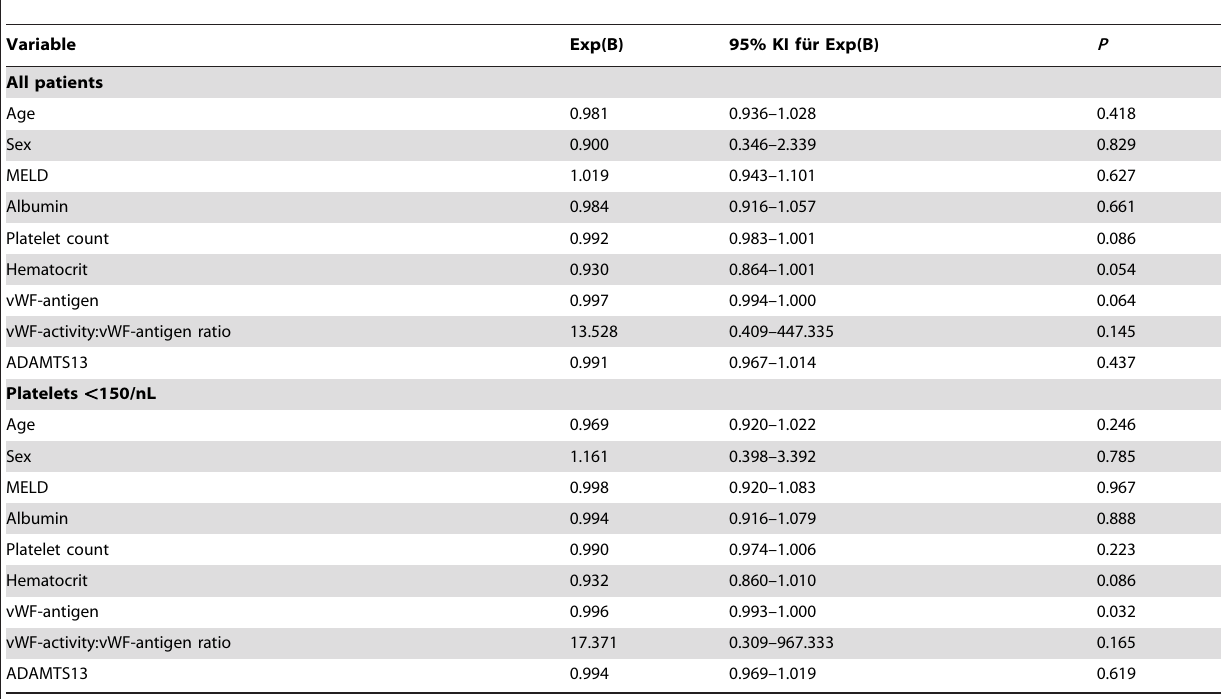
Table 5. Results for univariate analysis of predictors of a pathological PFA-100 test result.